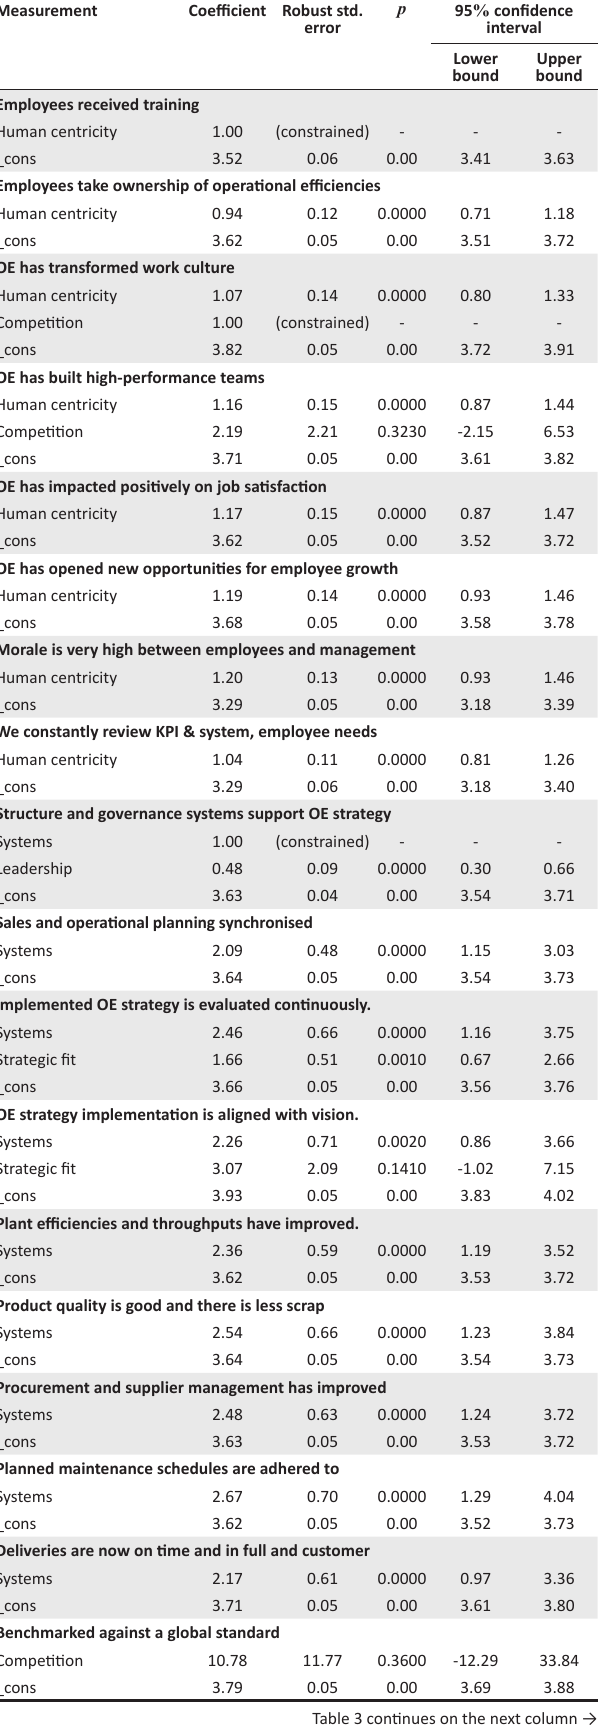
TABLE 3(Continues...): The structural equation model. Measurement Coefficient Robust std.